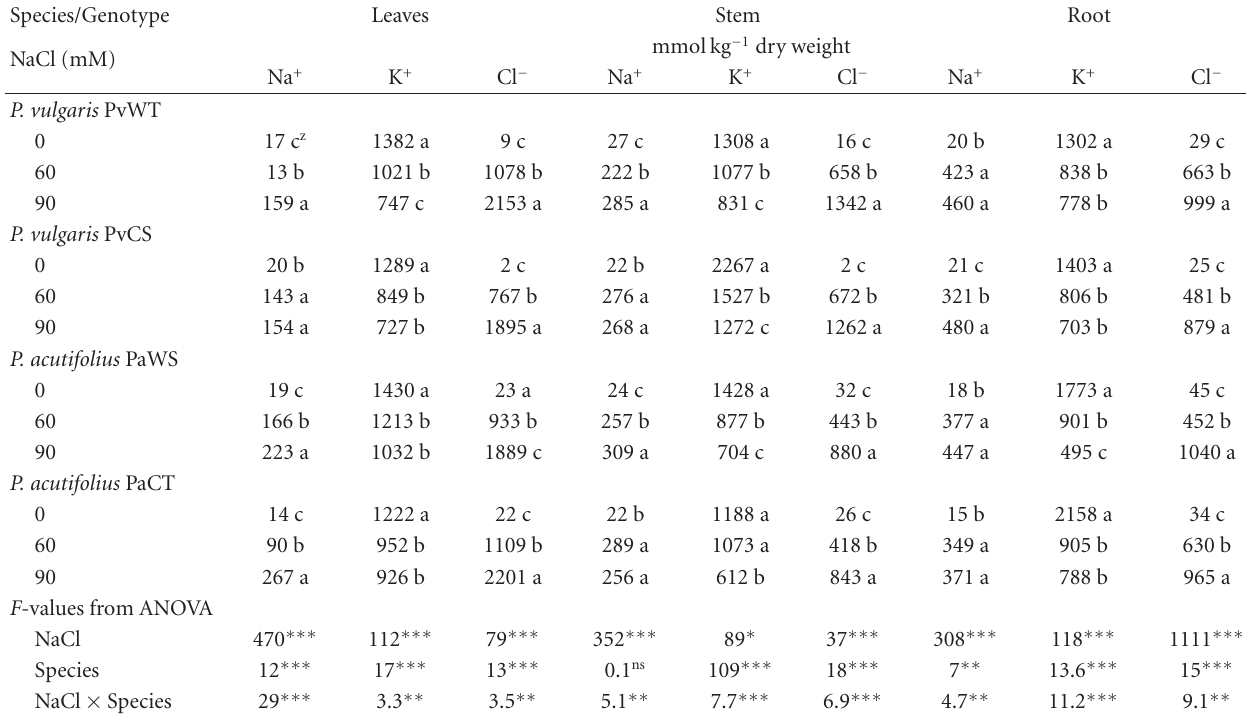
Table 1: E ff ects of external NaCl concentrations on mineral composition of leaves, stem, and roots of Phaseolus species. Species/Genotype